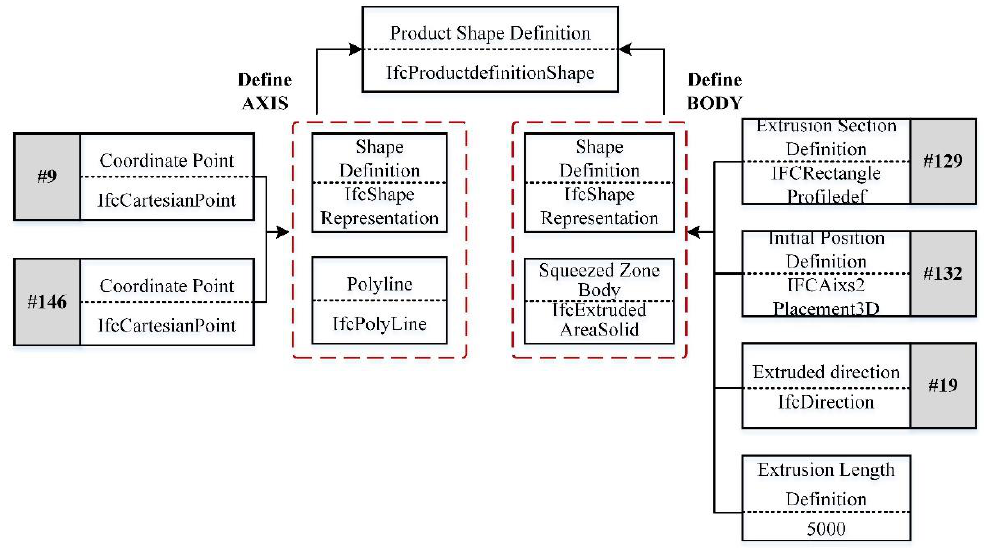
Figure 10. Process of beam geometry representation.